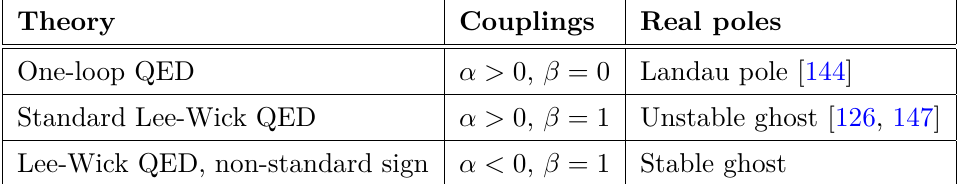
Table 1 . The table summarizes the existence and type of (real) massive poles for the generalized QED propagator in eq. (3.10). The values and positivity of the couplings α and β determine the specific theory, and the corresponding massive pole.